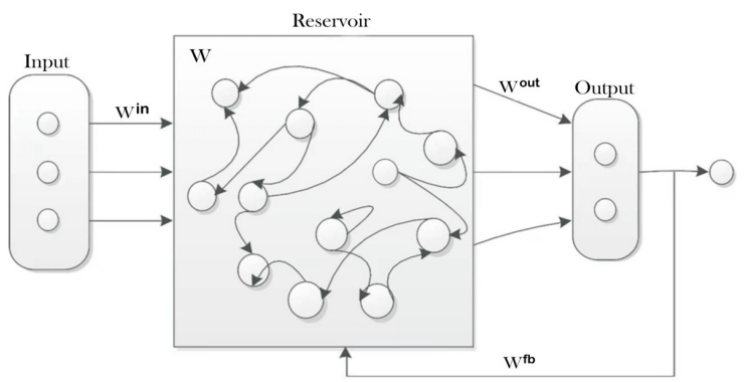
Figure 1. The structure of a standard